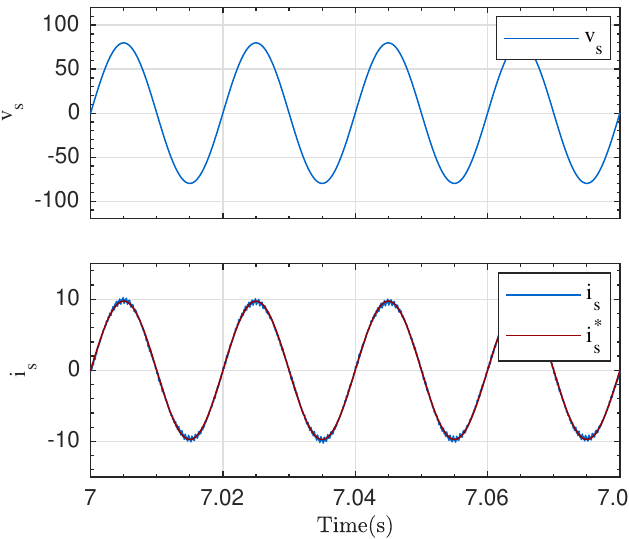
Figure 7. Steady-state operation of the grid current PMR control.